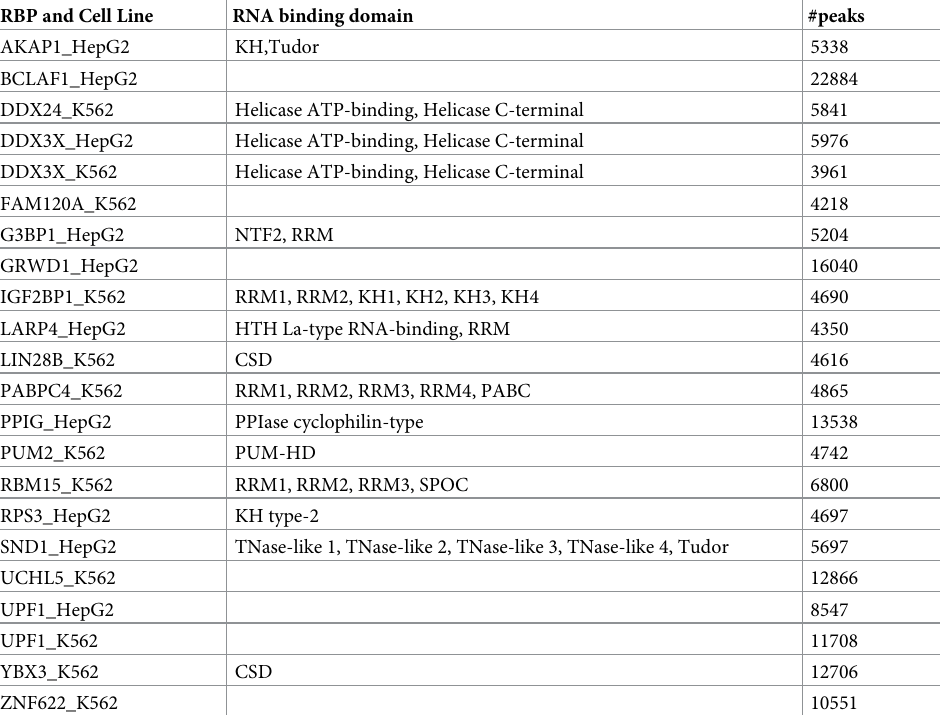
Table 3. RBPs and the domain information. RBP and Cell